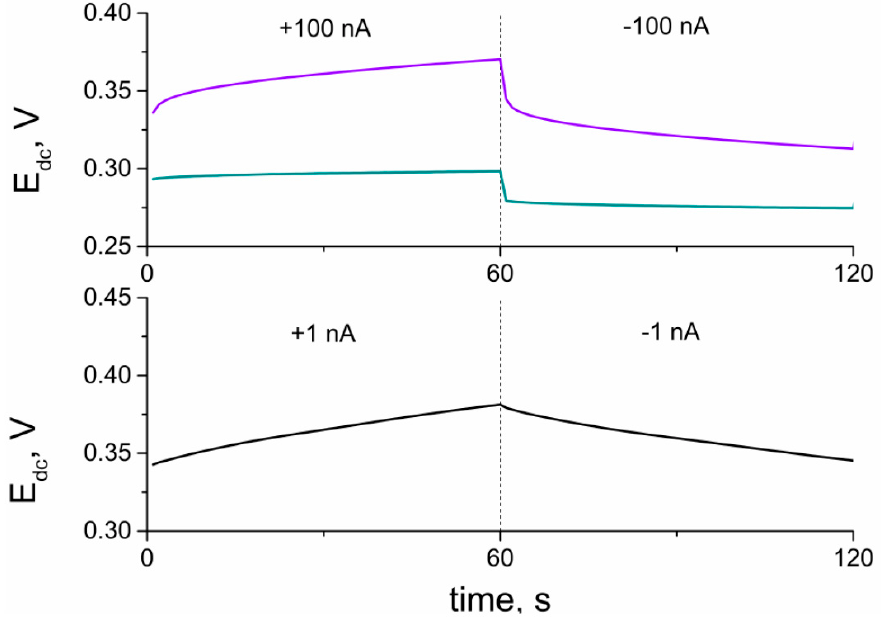
Figure 9. Part of chronopotentiograms recorded for solid contact electrodes: GCD/RuO 2 •xH 2 O/K + -ISM electrode (blue curve), GCD/RuO 2 /K + -ISM electrode (violet curve) and coated disc GCD/K + -ISM electrode (black curve).